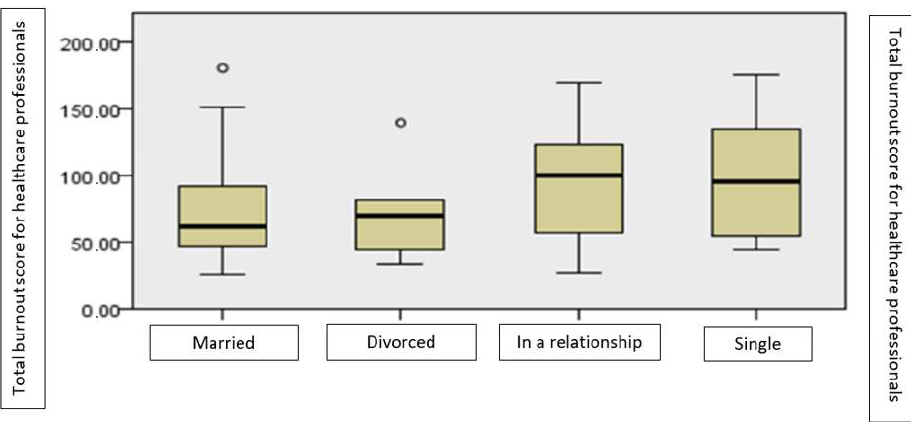
Figure 6. The average level of burnout according to participants’ relationship status.